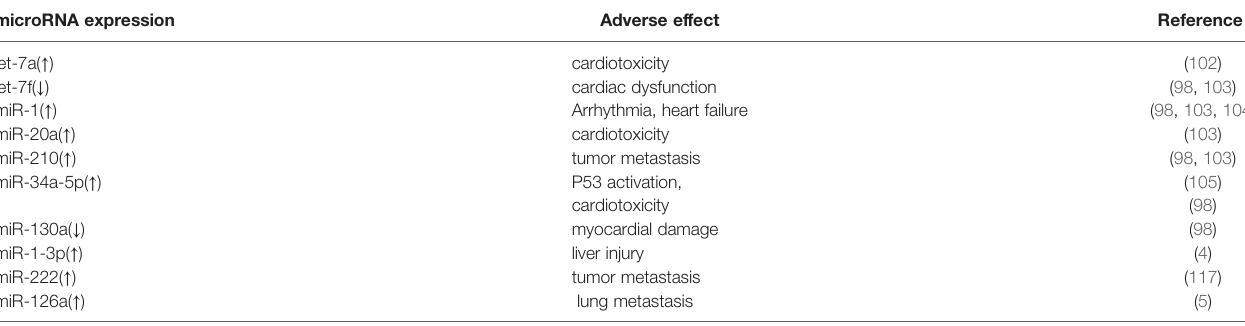
TABLE 1 | MicroRNAs involved in response to adverse effects linked to anthracyclines treatment in breast cancer. microRNA